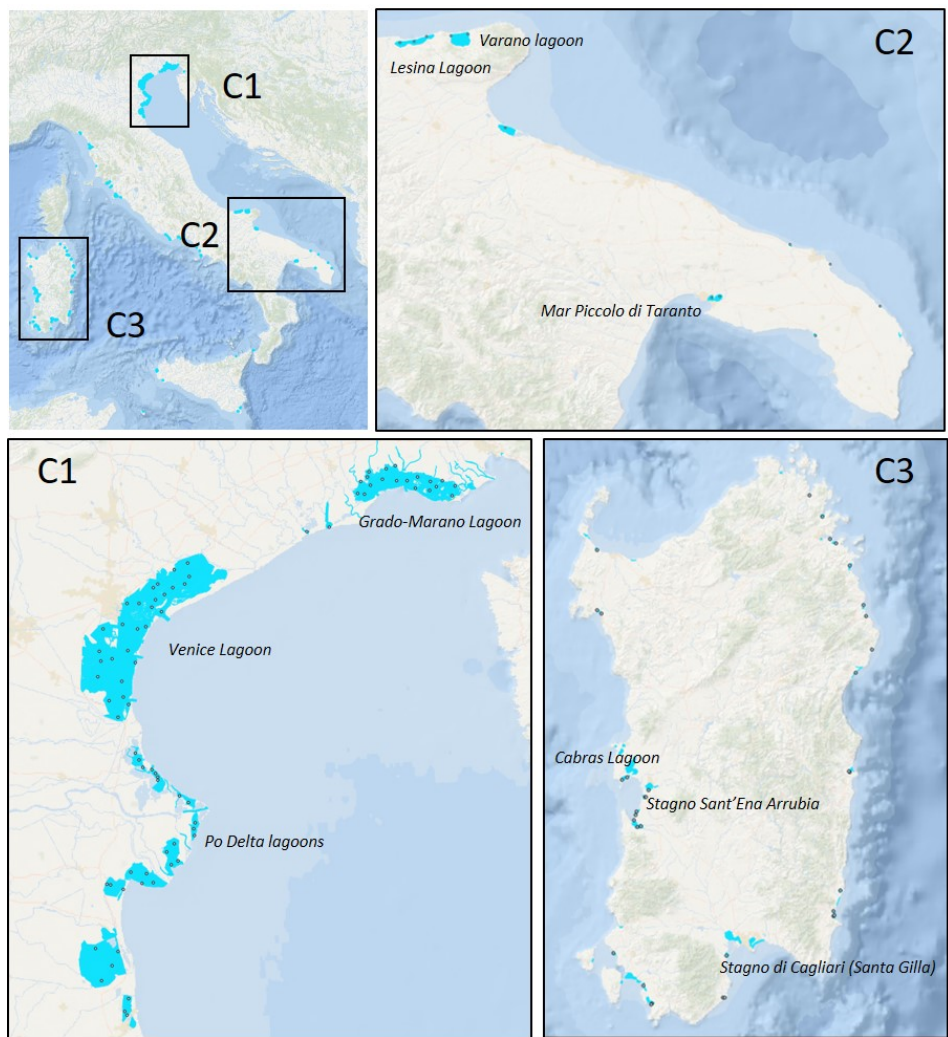
Figure 1. Study sites. C1: Northern Adriatic Sea compound; C2: Apulian compound; and C3: Sardinian compound.